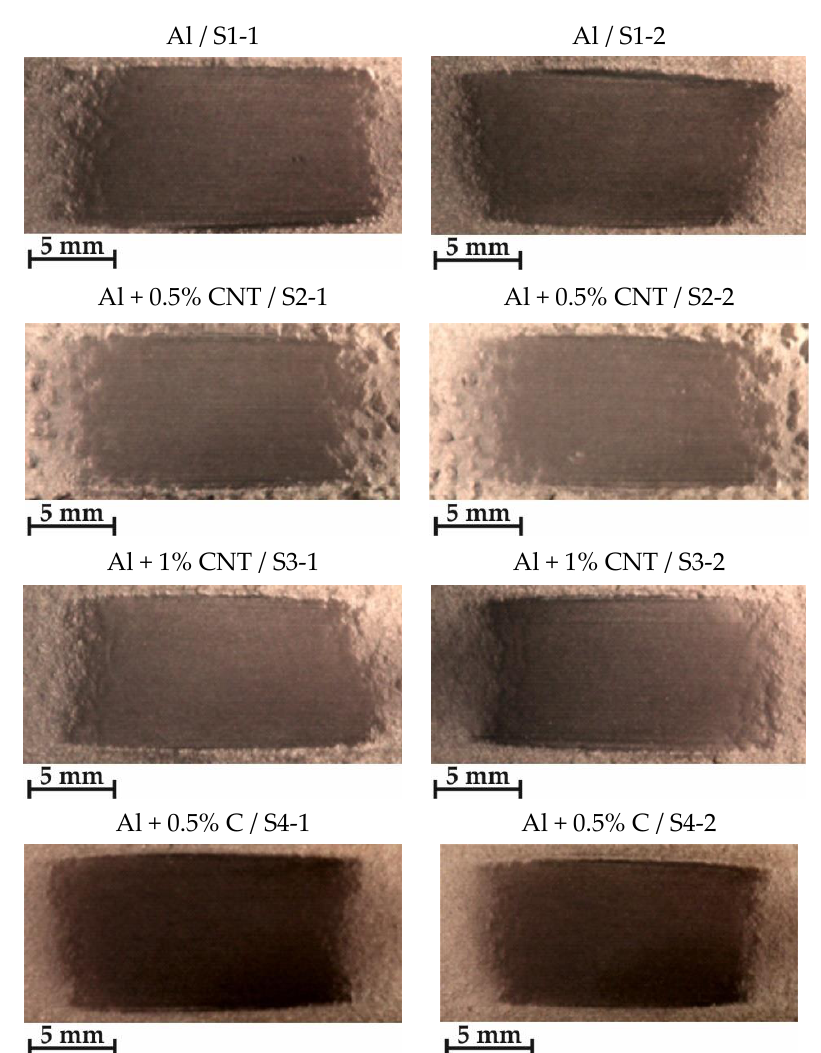
Figure 13. The surfaces of flame-sprayed aluminum and aluminum with carbon material coatings after wear resistance metal-mineral